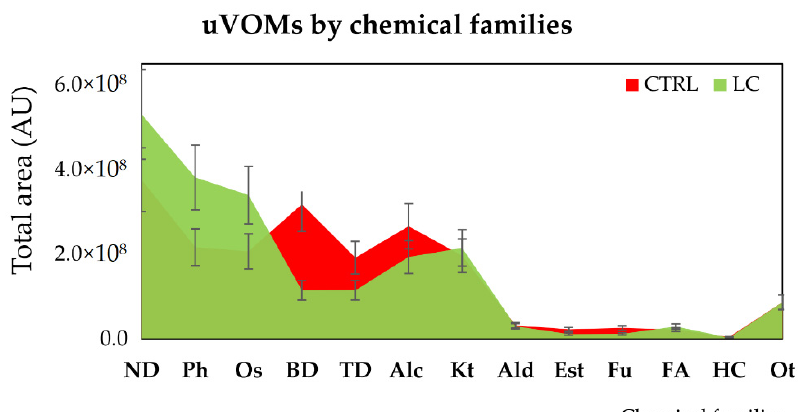
Figure 3. Figure 3. Distribution of the uVOMs identified in control (CTRL) and lung cancer (LC) individuals individuals by chemical